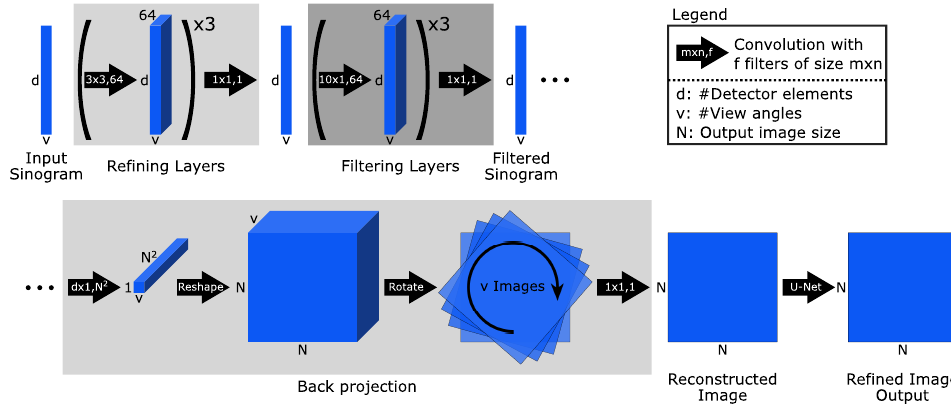
Figure A6. Architecture of the